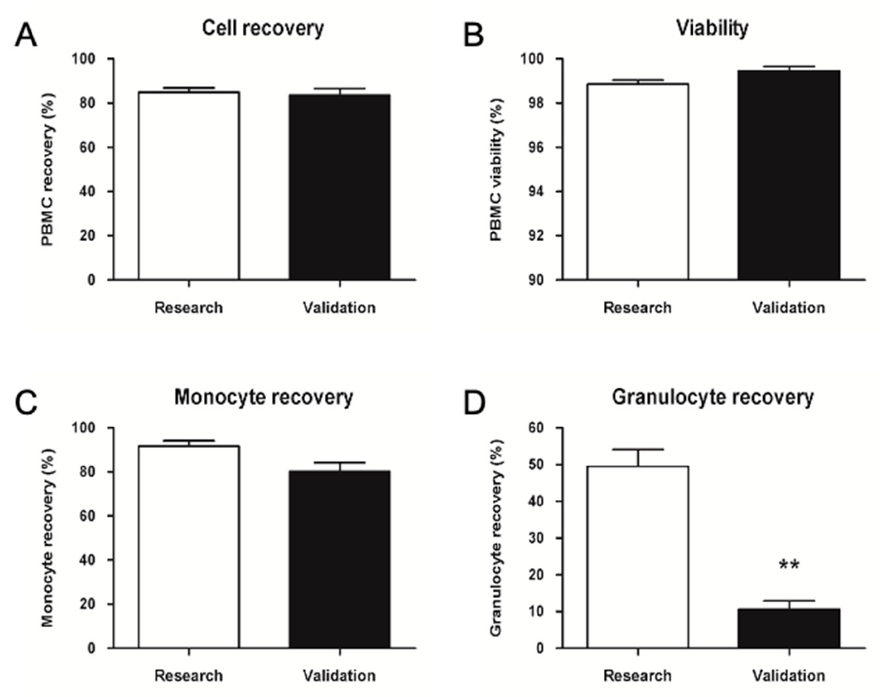
Figure 7. Validation of PBMC cryopreservation and thawing in a GMP-compliant aseptic environment (clean room). Average recovery percentage of nucleated cells ( A ), viability ( B ), monocyte ( C ) and granulocyte ( D ) recovery percentages. Date are represented as mean ± SEM. Research N = 27, Validation N = 3. ** = p <